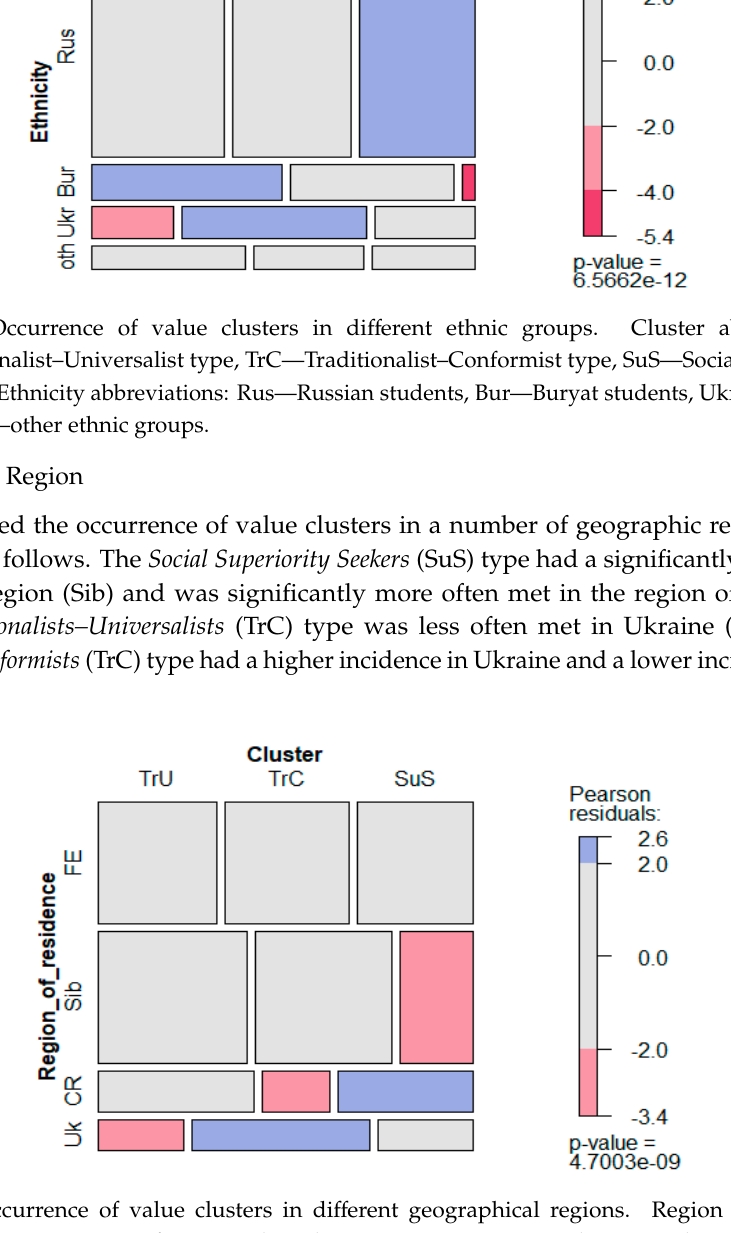
Figure 5. Occurrence of value clusters in different geographical regions. Region of residence